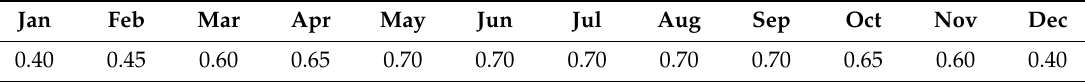
Table 3. Estimated common average shading coe ffi cients for all the windows of the